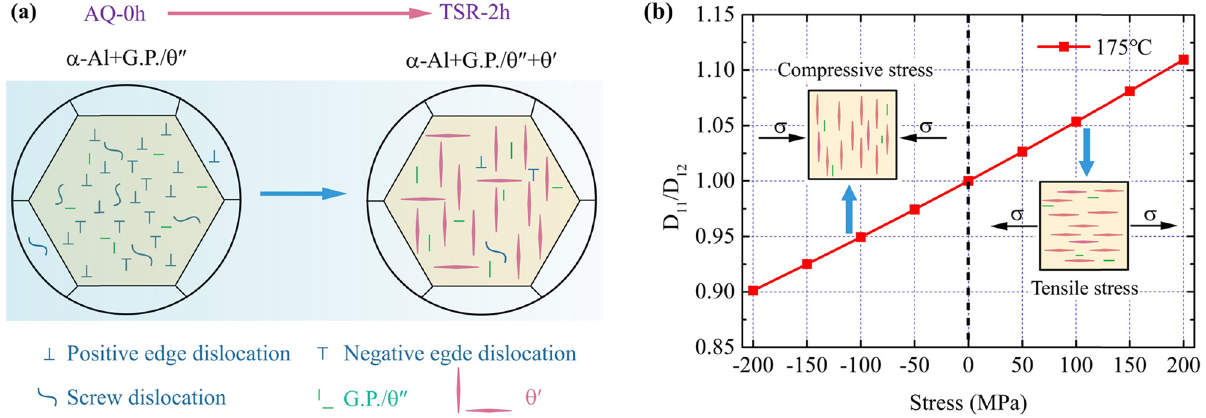
Figure 11: Schematic illustration of strengthening mechanisms of 2219 alloy during TSR at 175°C for 2 h: ( a ) microstructural evolution, and ( b ) di ff usion coe ffi cient ratio along two di ff erent directions under stress. The shadow represents the solid solution